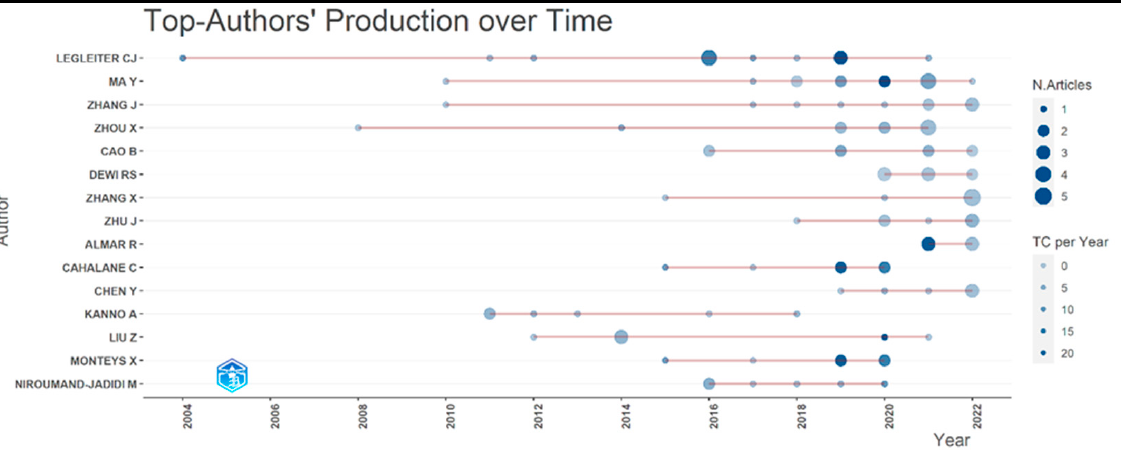
Figure 11. Top authors’ production over time (WoSCC and Scopus).